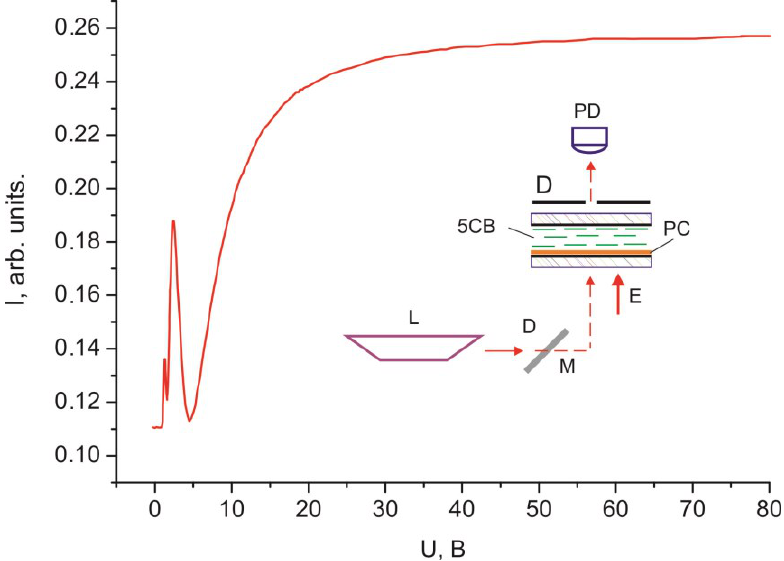
Figure 3. Voltage dependence of intensity I of monochromatic light passed through the 30 µm thick planar 5CB layer with domains formed on the PC